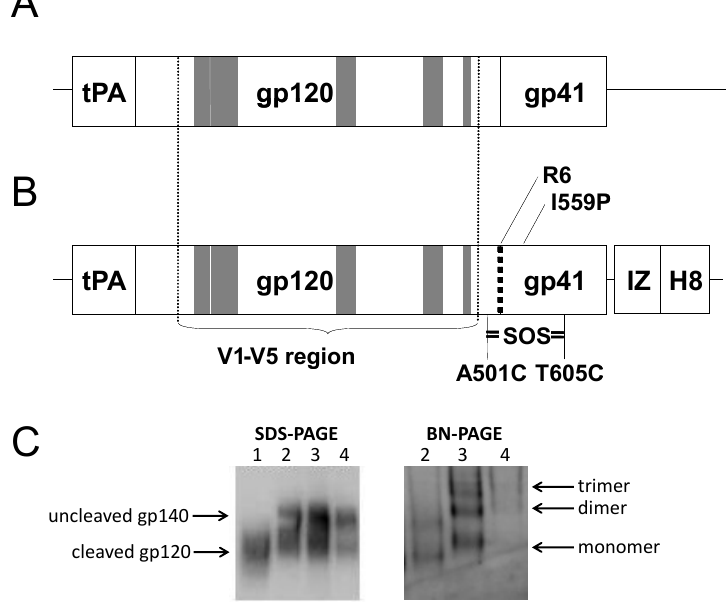
Figure 3. Schematic representation of HIV-1 envelope DNA constructs and protein expression. DNA constructs encoding gp140. The tissue plasminogen-activator leader sequence (tPA) and the region encoding the variable regions V1 to V5 are indicated (grey boxes). ( A ) The gp140 construct with V1-V5 region from ctl21 and ctl27 env flanked by Bx08 env . ctl21/27 ( B ) DNA construct encoding modified gp140 including the SOSIP amino acid substitutions A501C, T605C and I559P (SOSIP), the hexa-arginine cleavage site (R6), the introduced isoleucine-zipper motif (IZ) and the histidine tag (H8). ( C ) Western blot analysis of protein expression (SDS-PAGE) and oligomerization (Blue-Native PAGE) of Env Bx08